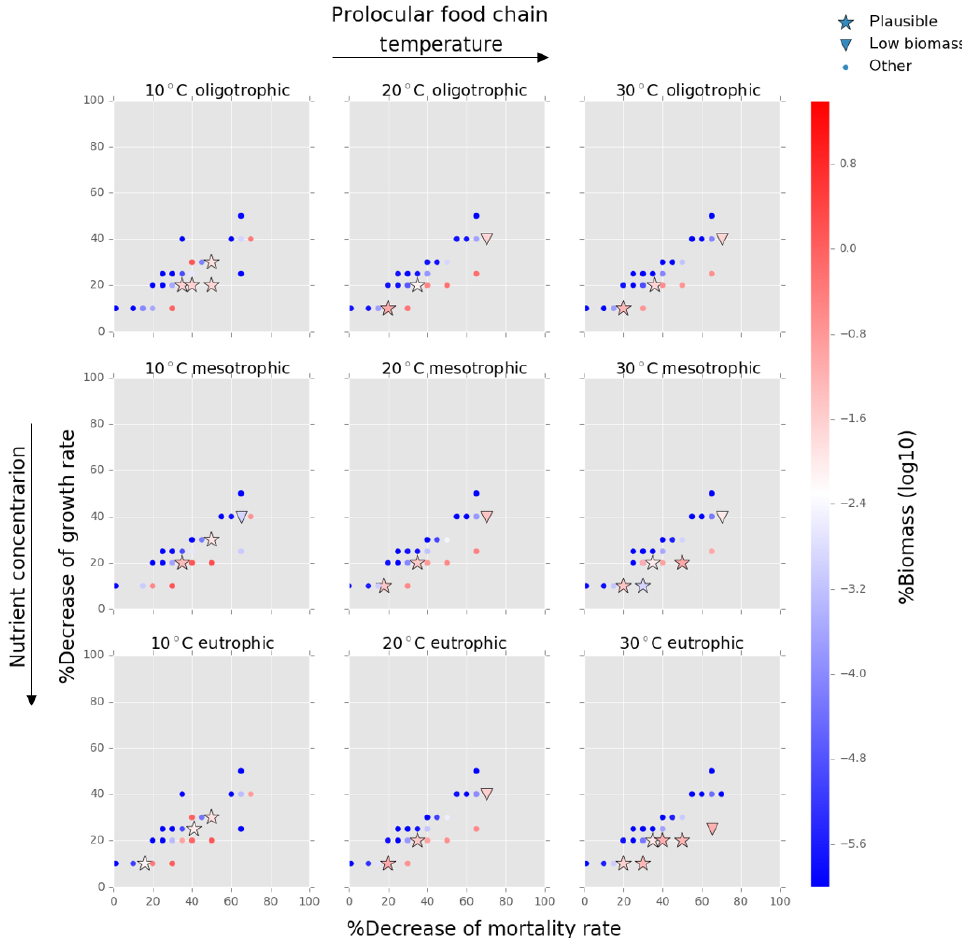
Figure 4. Results from the food chain model for the calcification cost (reduction of growth) and benefit (reduction of mortality rate) for the prolocular life stage of planktonic foraminifera. Legend shows “other” for total tested simulations, low biomass for simulations for which their biomass is within the defined range and plausible for the simulations we consider to be as most likely. More details on low biomass and plausible simulations are given in Sect. 2.3, “Adding planktonic foraminifera to the